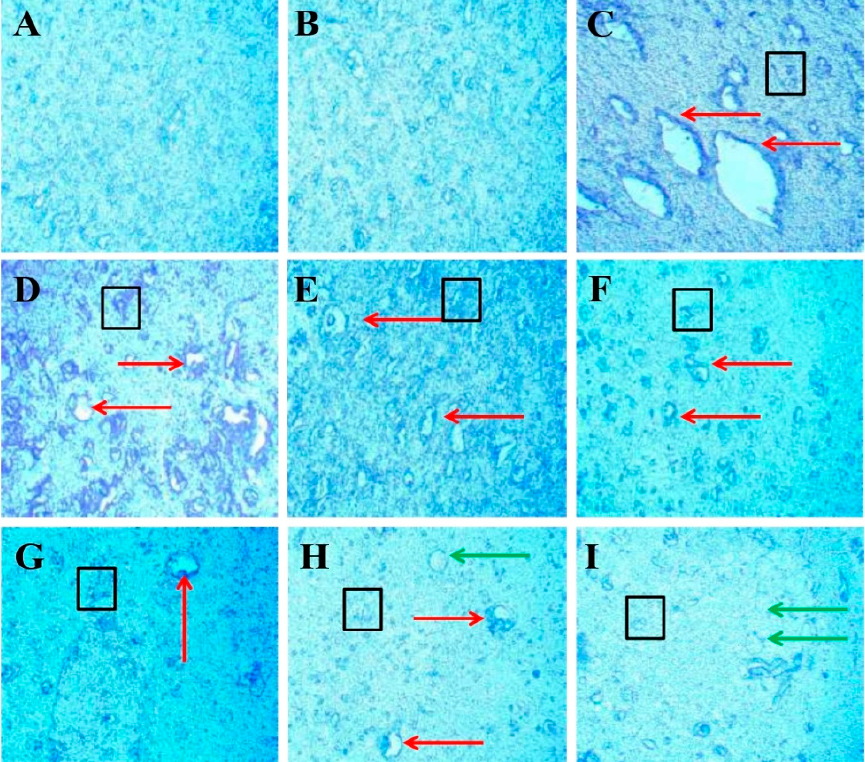
Figure 13. Protective role of FSK on remyelination in experimental multiple sclerosis rats. Brain sections stained with the LFB indicate the demyelinated and remyelinated areas. Clear white lesions show the brain’s demyelination, while blue indicates the normal myelination area in the brain. The red arrow indicates the demyelinated regions caused by the destruction of oligodendrocytes in the brain, the black boxes indicate the swelling of the axons, and the green arrow indicates the shadow of plaques that indicate the remyelination occurred. ( A ) Diagram shows the positive stain intensity with high no. of oligodendrocytes in the normal group. ( B ) Diagram shows no change in the number of oligodendrocytes, and no sign of demyelination occurs when comparing FSK40 per se with the normal group. ( C ) Diagram shows the demyelinating lesions in the brain with axonal swelling in EB ‐ induced rats. ( D , E ) Diagrams show the effect of a low dose of FSK40 and a high dose of FSK60 on the reduction in demyelination and axonal swelling. ( F – I ) The dia ‐ grams showed the significant demyelination and axonal swelling reduction when EB ‐ induced rats were treated with the high dose of FSK60 and standard drugs (F ‐ DON, G ‐ MEM, H ‐ SIM, G ‐ FNG), respectively. ( F ) Diagram also shows remyelination occurs in the form of the shadow of plaques.